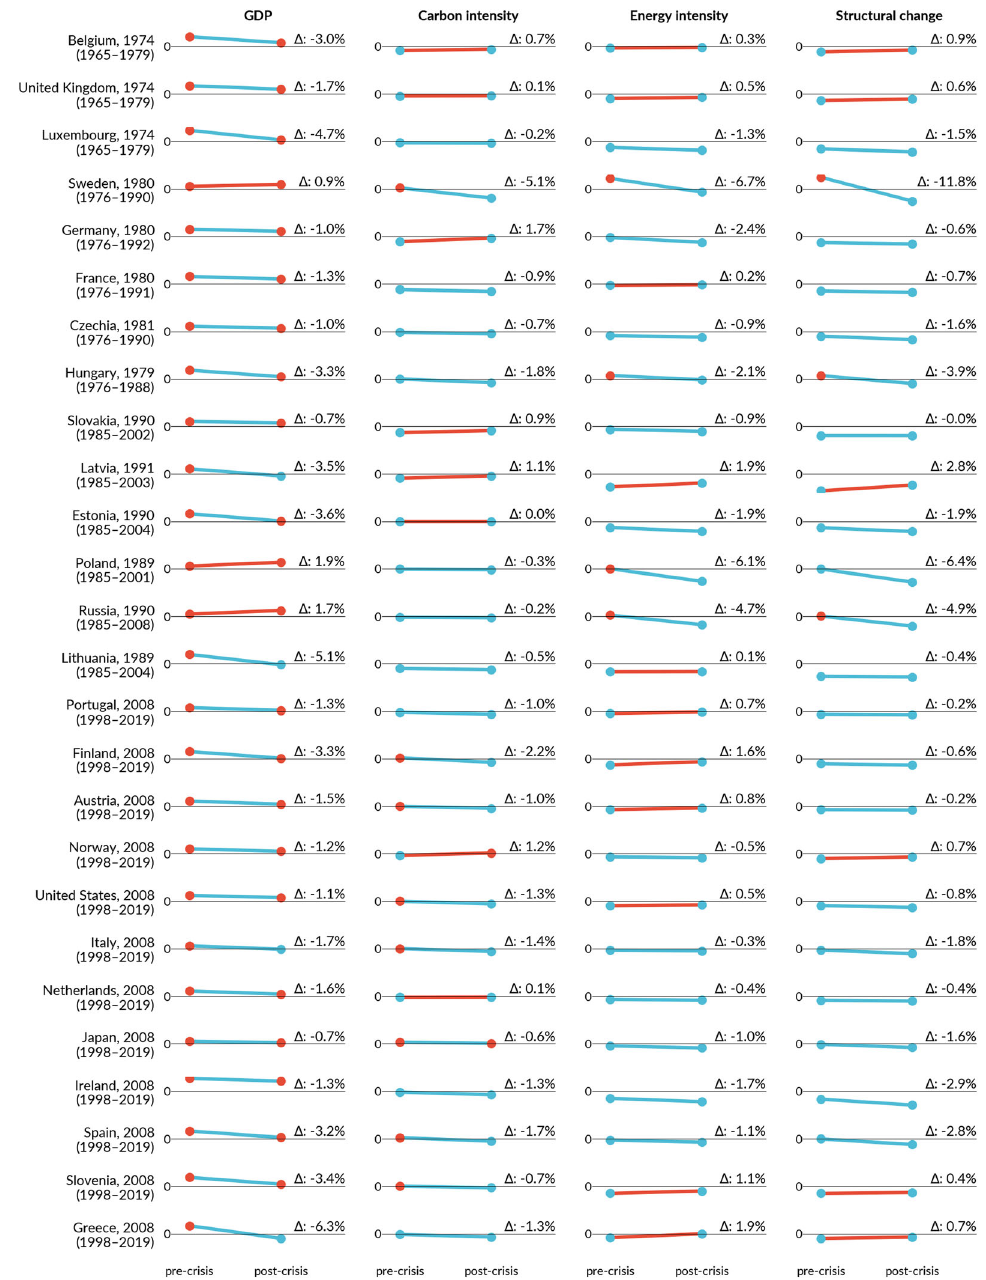
Fig. 3 Decomposition of CO 2 emission drivers in peak-and-decline countries. Changes in growth rates (% per year) of contribution factors to carbon emissions before ( fi rst point) and during and after (last point) the economic crisis associated to the CO 2 peak, based on the Kaya identity and multiplicative decomposition. GDP includes population and GDP per capita factors. Structural change is the change of combined energy and carbon intensity factors. Red (blue) circles mean that the factor increased (reduced) emissions; red (blue) lines indicate that the change from pre- to post-crisis was negative (positive) for decarbonisation. The year after the country name denotes the fi rst year of recession and the period below the country name denotes the entire analysed period. Source: 31,32,57